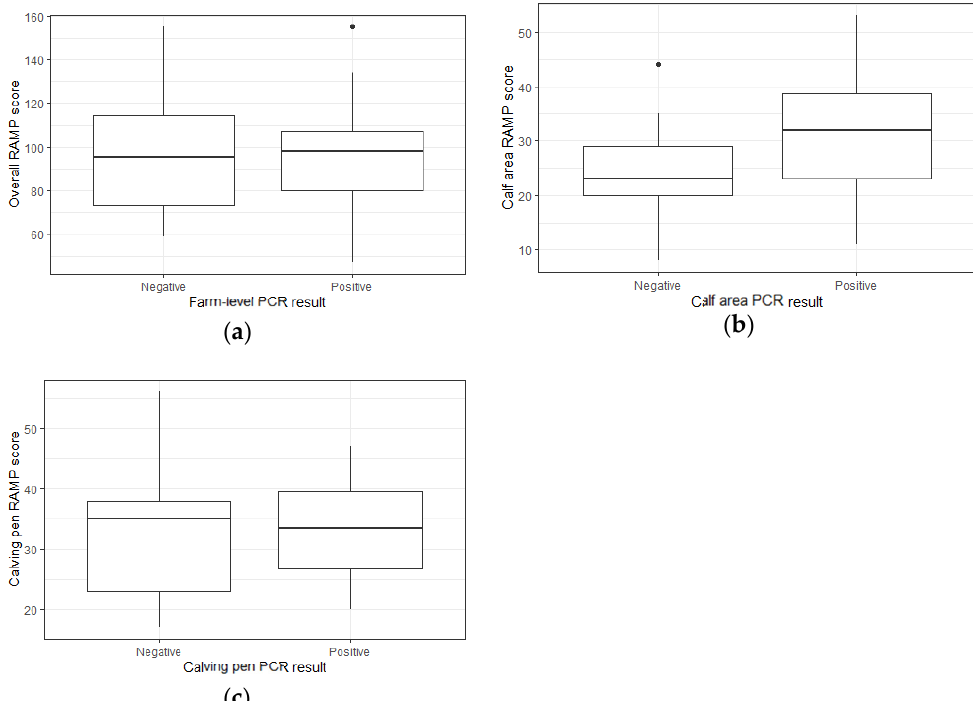
Figure 1. Boxplots illustrating the distribution of RAMP scores for the overall farm ( a ), pre-weaned calf area ( b ) and the calving area ( c ). The black dots in the graphs represent outliers in the data. The mean RAMP scores for calf pens across farms that were PCR-positive for calf pens and PCR-negative for calf pens were 31.5 and 23.7, respectively, with no